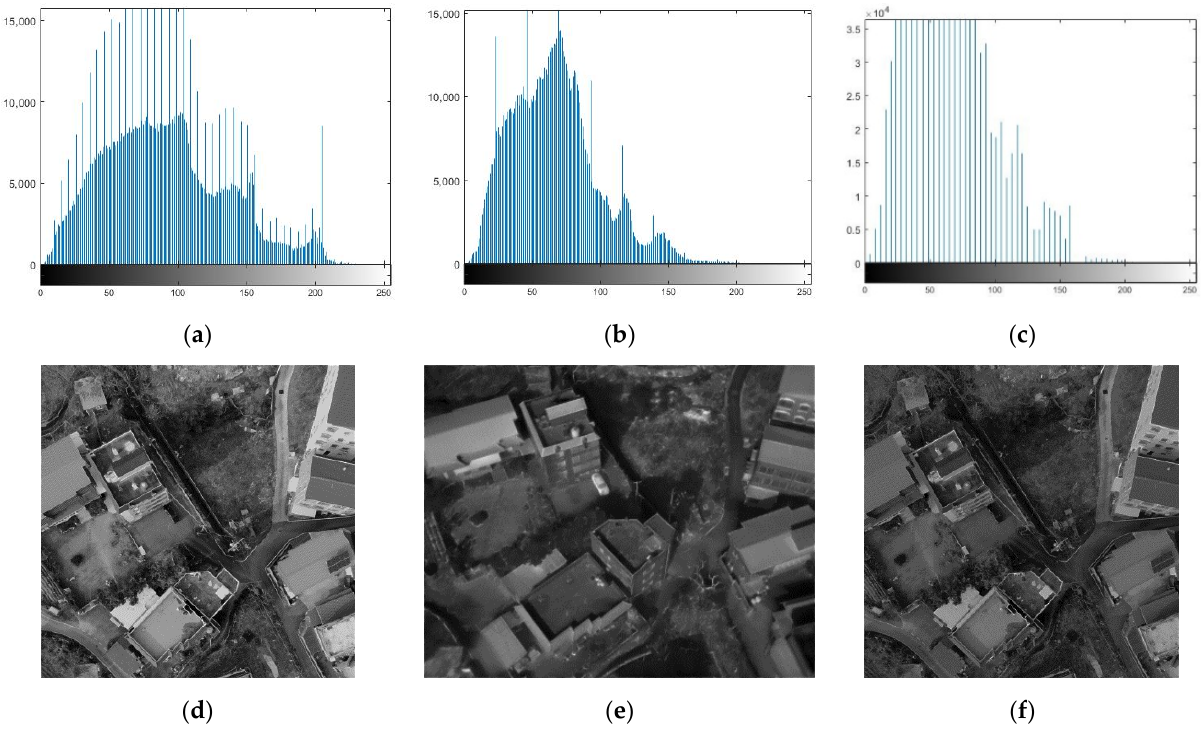
Figure 3. Histogram matching: ( a ) histogram of combined visible image; ( b ) histogram of combined TIR image; ( c ) adjusted histogram of the combined visible image; ( d ) combined visible image; ( e ) combined TIR image; ( f ) adjusted combined visible image.